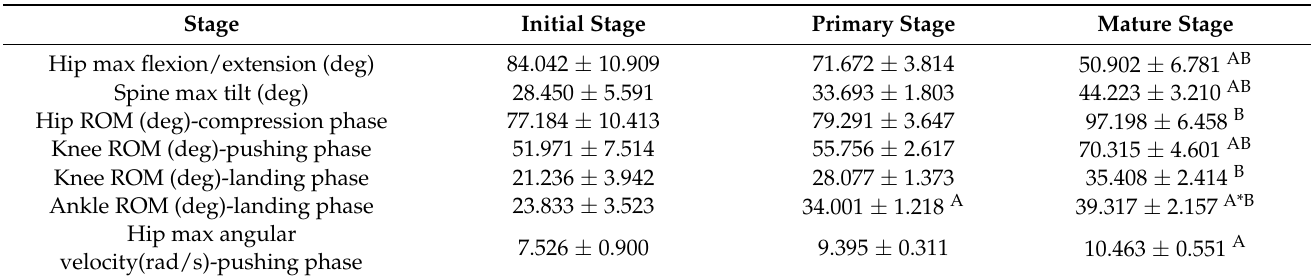
Table 5. Results of stage effect of joint